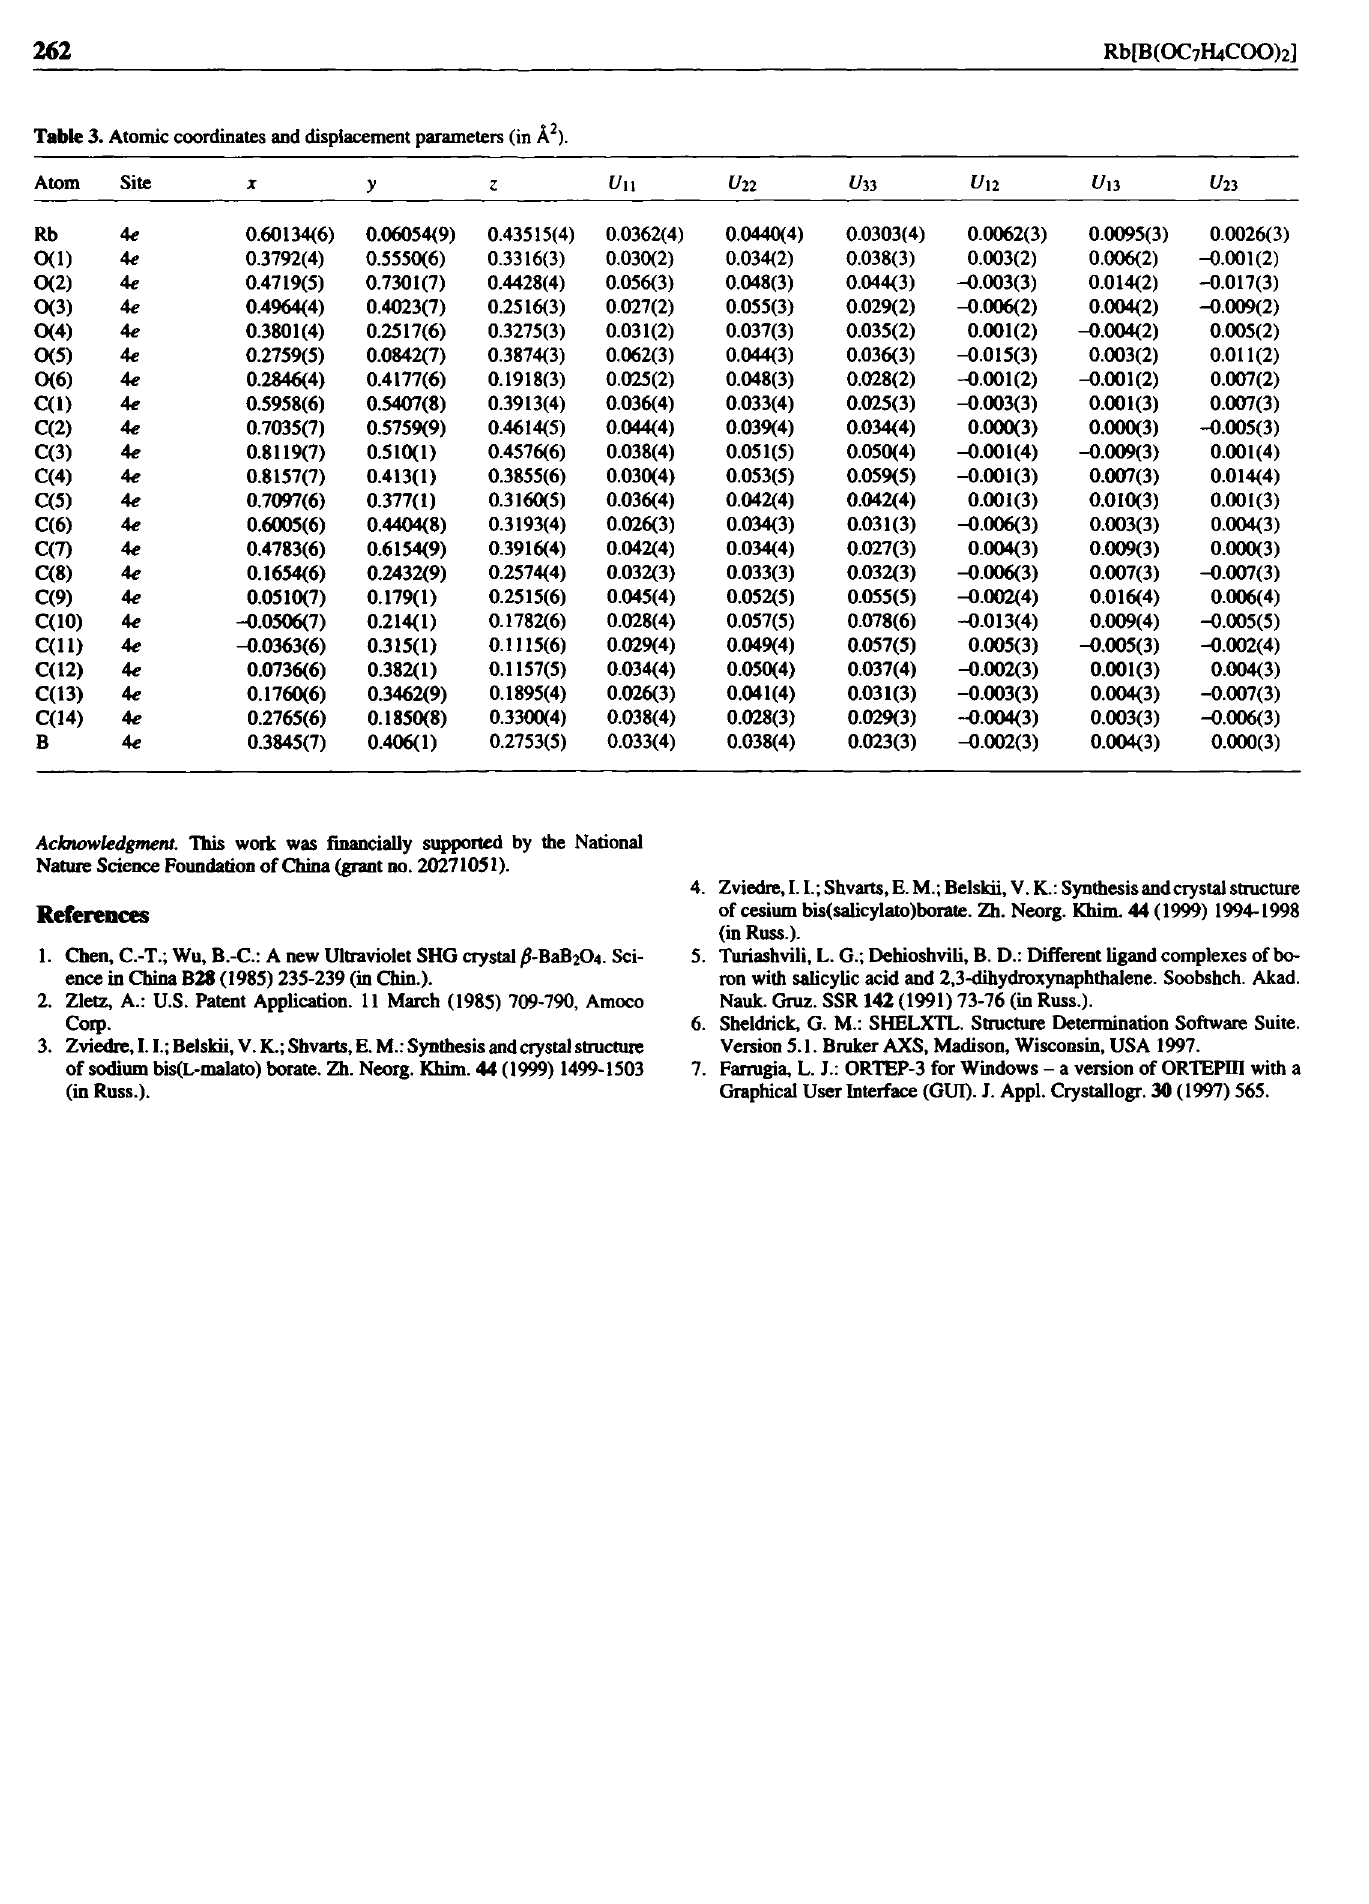
Table 3. Atomic coordinates and displacement parameters (in A 2